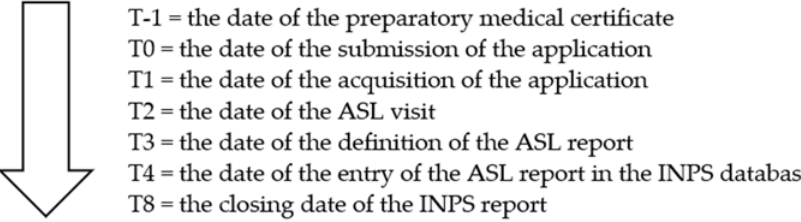
Figure 1 – Dates of the disability assessment process